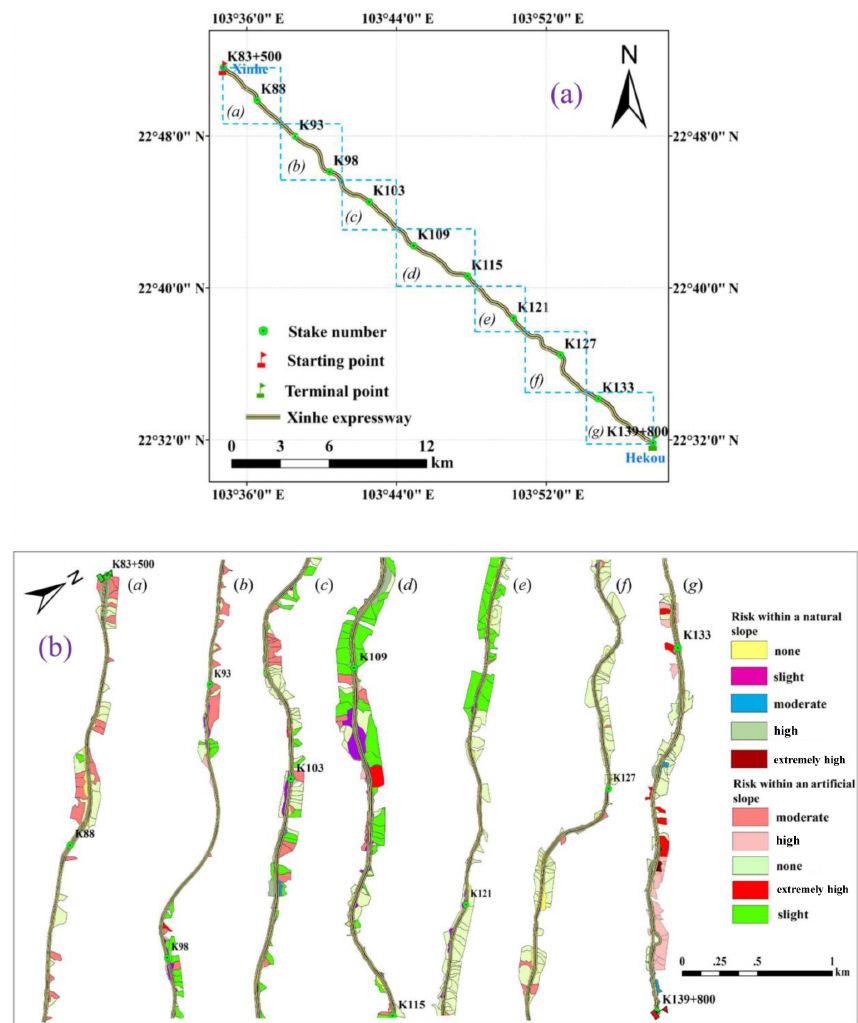
Figure 15. (a, b) Risk analysis of soil loss under a 20-year return period rainfall